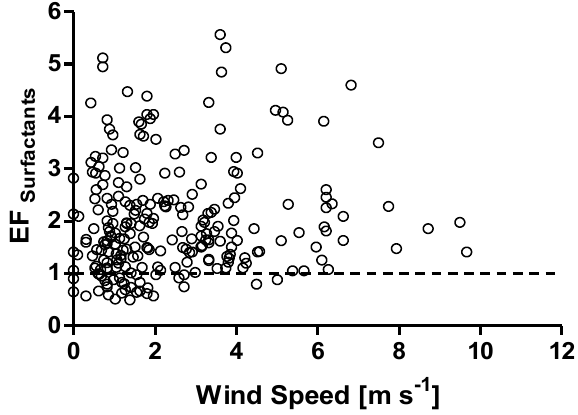
Fig. 2. Mean enrichment factor (EF) of surfactants at the three trophic states. The bars represent the 95% confidence interval of the mean. The chosen treshold enrichment values are indicated as lines: weak influence ( ····· , EF = 1.0); moderate influence (---, EF = 1.5); and stronger influence (—, EF = 2.0).